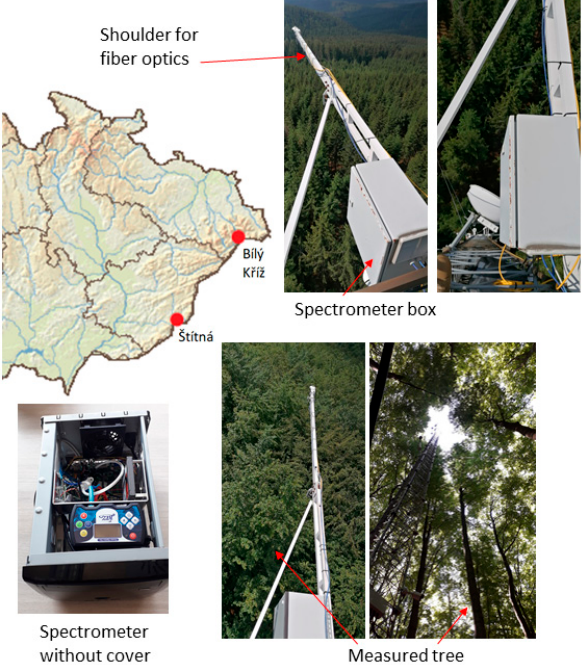
Figure 1. Positions of Bílý K ř íž and Štítná experimental sites within the Czech Republic. Photographs show instrumentation used for measurements of canopy sun-induced fluorescence at both sites. The upper row photos show the layout of instruments at the Bílý K ř íž site; lower row photos display instrumentation in the beech forest at the Štítná site.